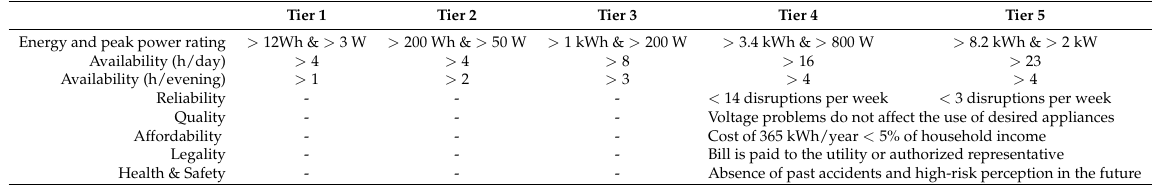
Table 1. Multi-tier matrix for measuring access to household electricity supply. Sourced from [6]. Tier 1 Tier 2 Tier 3 Tier 4 Tier 5 Energy and peak power rating > 12Wh & > 3 W > 200 Wh & > 50 W > 1 kWh & > 200